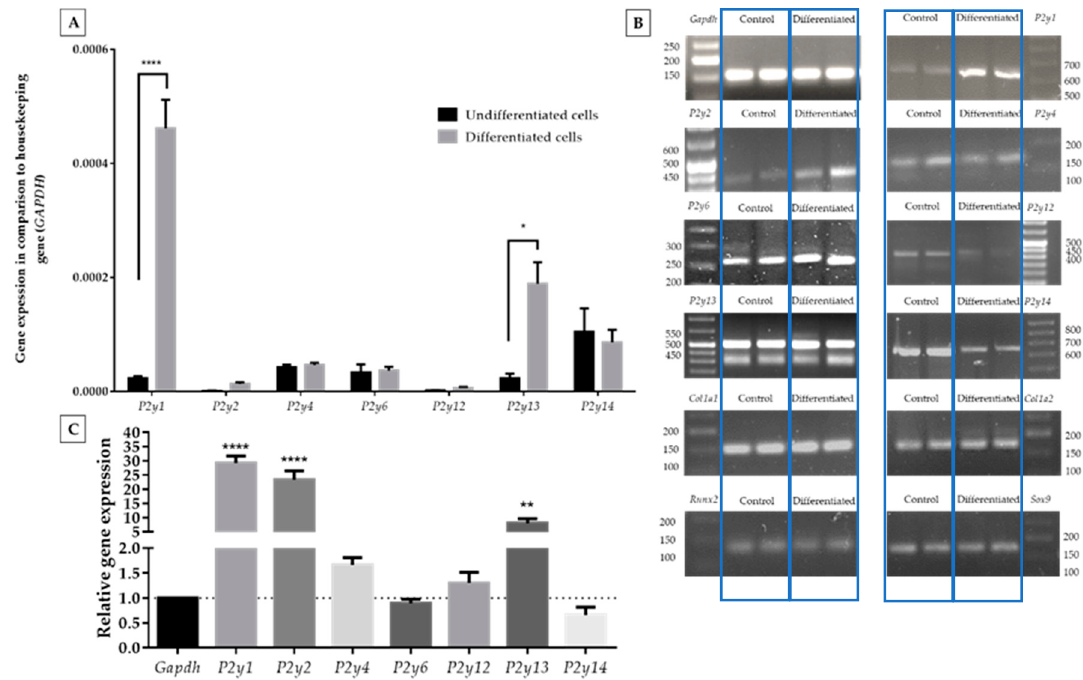
Figure 2. Comparison of P2Y receptor gene expression levels between ATDC5 cells grown in standard growth medium or in differentiation medium in comparison to a Gapdh housekeeping gene ( A ). Significant differences were calculated with two-way ANOVA with Tukey post-hoc test. The relative gene expression calculated with Livak’s method [24] showed changes in the expression level while Gapgh was constant ( C ). An image of DNA qPCR products separated on a 3% agarose gel (two repeated samples in each case) along with a DNA ladder and documented with the ChemiDoc Imaging system ( B ). qPCR products were separated with 3% agarose gel electrophoresis and documented with the ChemiDoc Imaging system ( B ). Statistical differences vs. control were calculated with one-way ANOVA. Data represent the means ± SEM from at least three independent experiments. p < 0.05 (*), p < 0.01 (**), and p < 0.0001 (****) for gene expression significantly different from undifferentiated control cells.